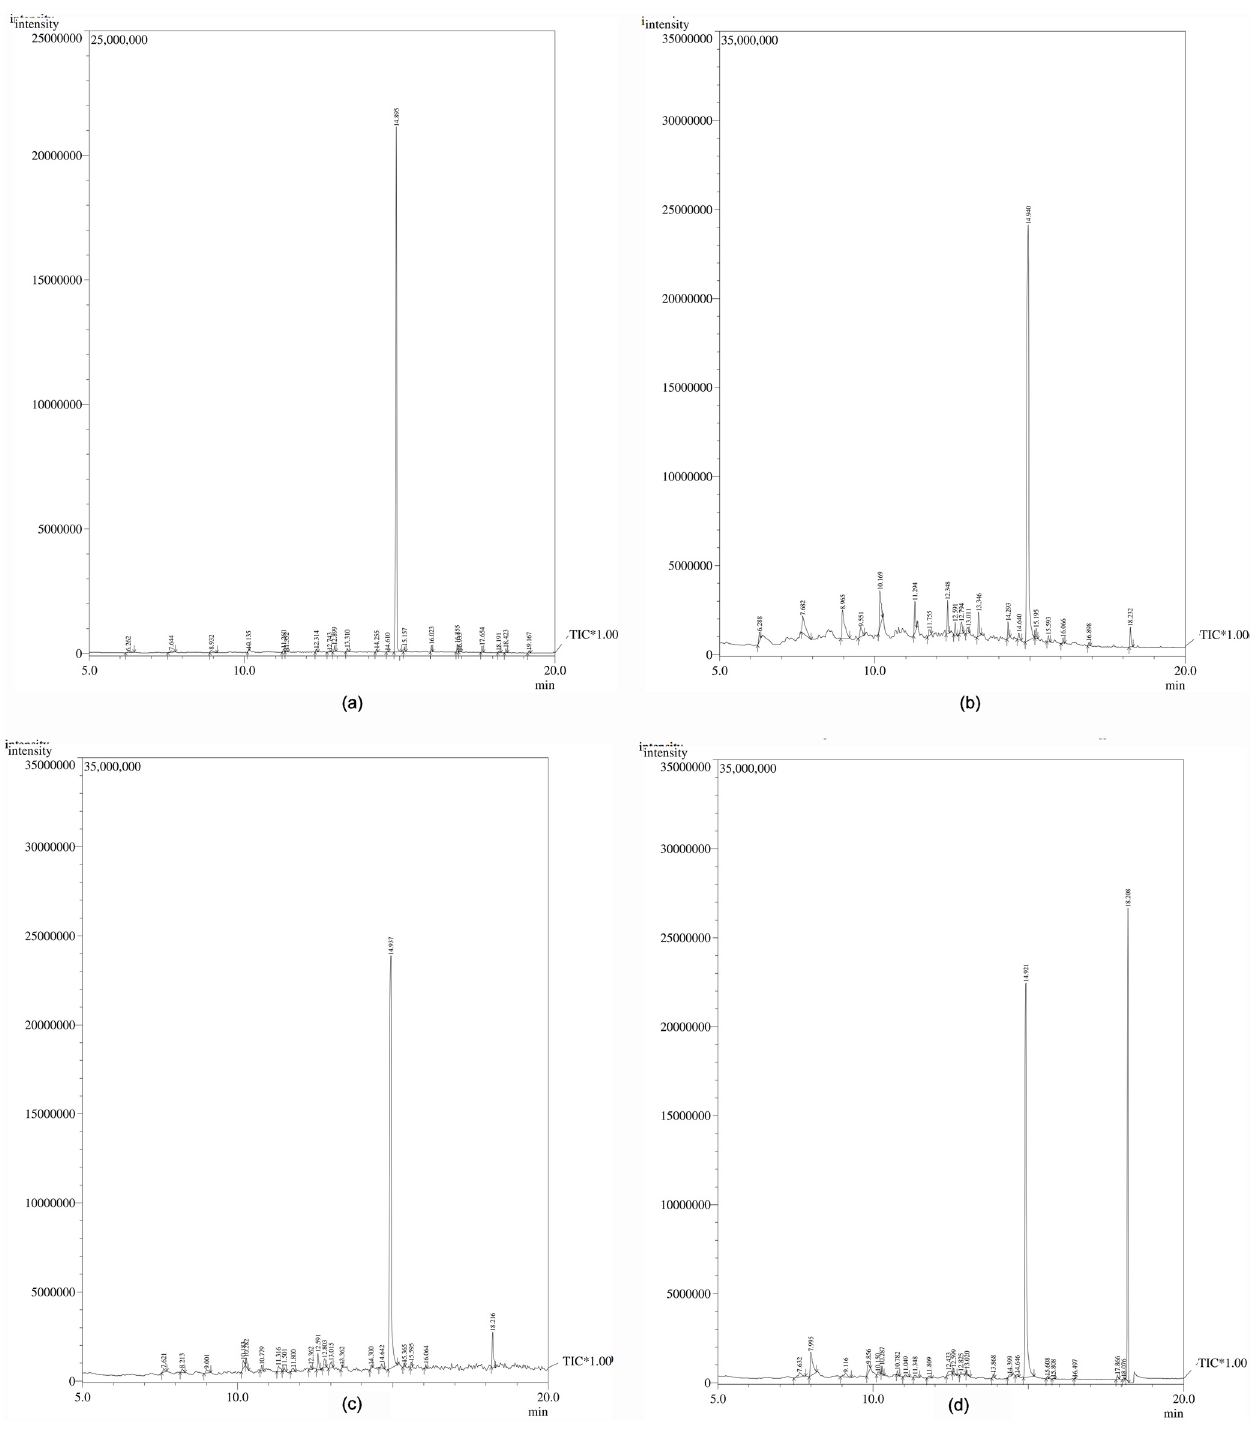
Fig 8. GC charts of the reaction products of AKR17A1 with butachlor used as substrate. (a) Control assay devoid of enzyme AKR17A1 and cofactor (NADPH); (b) reaction with NADPH alone; (c) enzymatic reaction with AKR17A1 alone; and (d) enzymatic reaction with both AKR17A1 and cofactor NADPH.